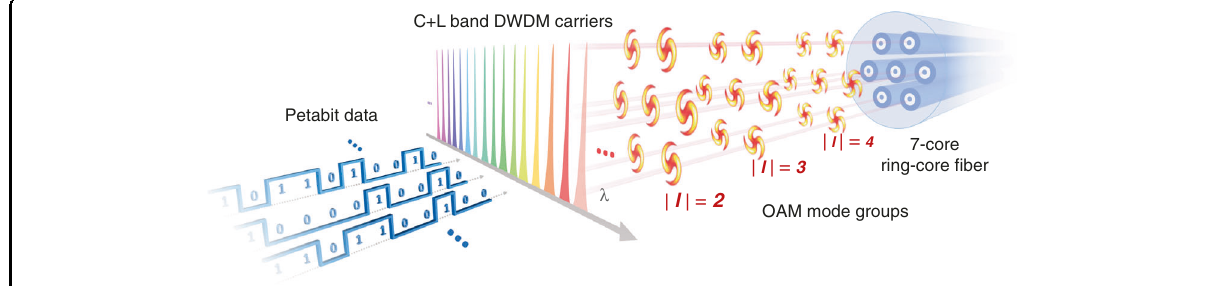
Fig. 2 An illustration of the 1Pbps OAM-SDM-WDM multiplexing scheme. The system combines the C + L band WDM channels, spatial/mode multiplexing as well as the 34-km 7-core RCF to realize 1Pbps